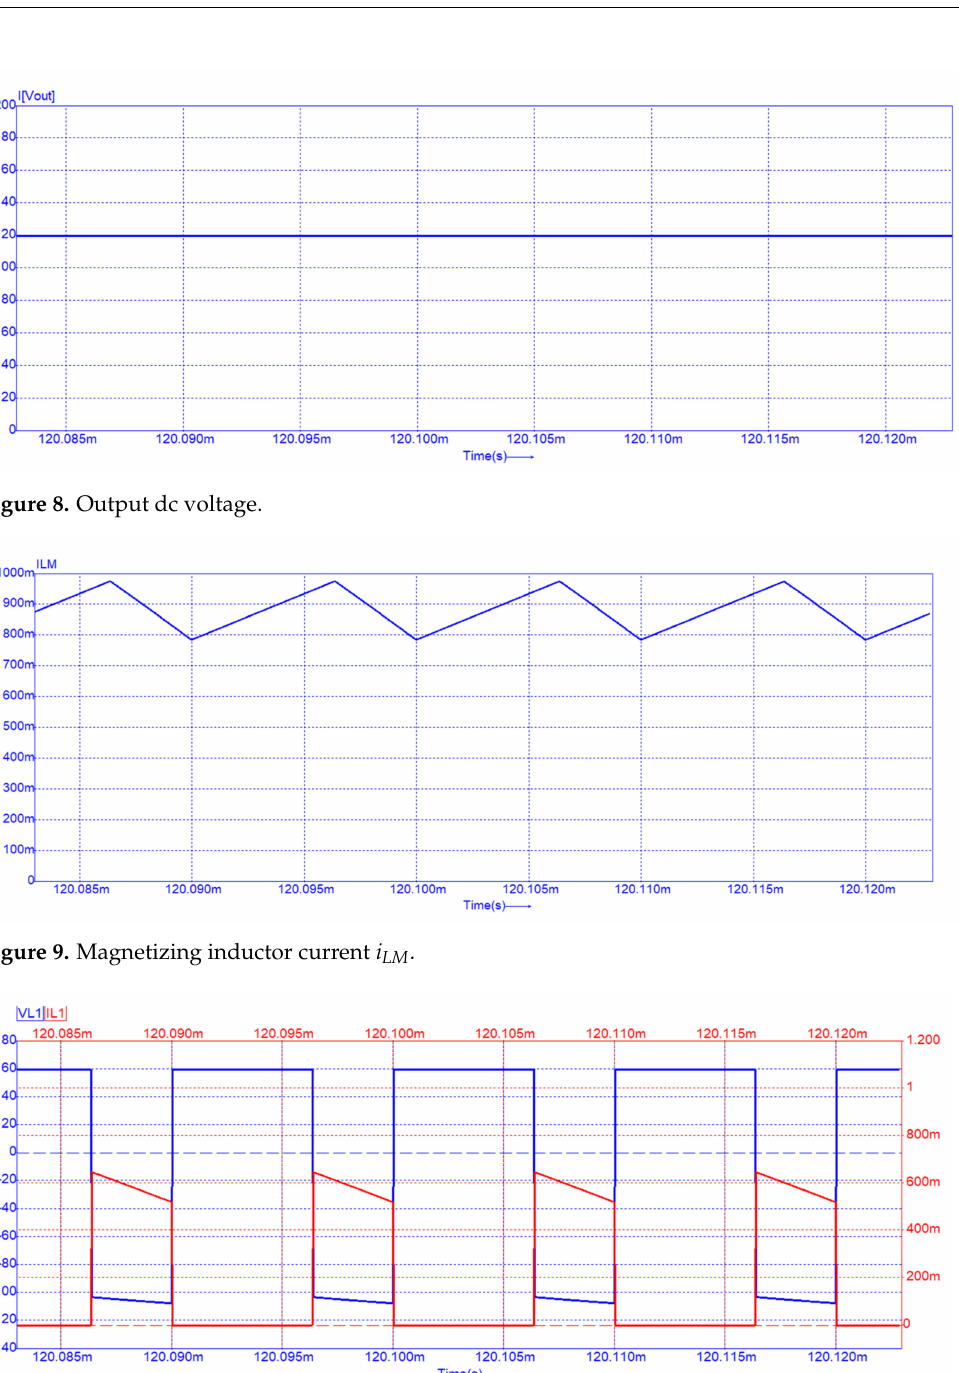
Figure 10. Voltage (blue) and current (red) of the primary winding L 1